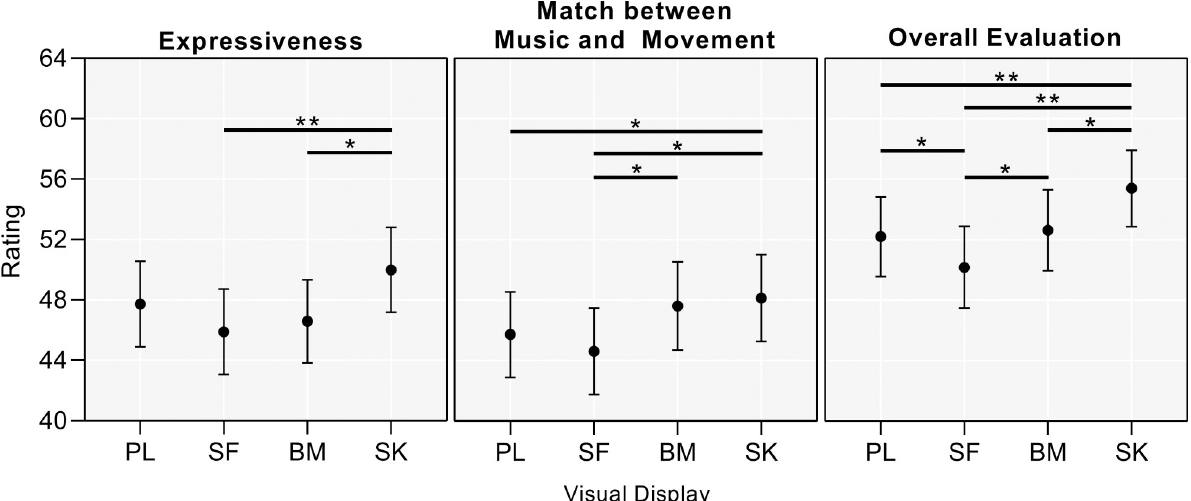
Fig 2. Mean ratings (with 95% confidence intervals) and significant differences between the four visual displays. PL: point-light; SF: stick-figure; BM: body-mass; SK: skeleton; � stands for p < 0.05; �� stands for p < 0.01.